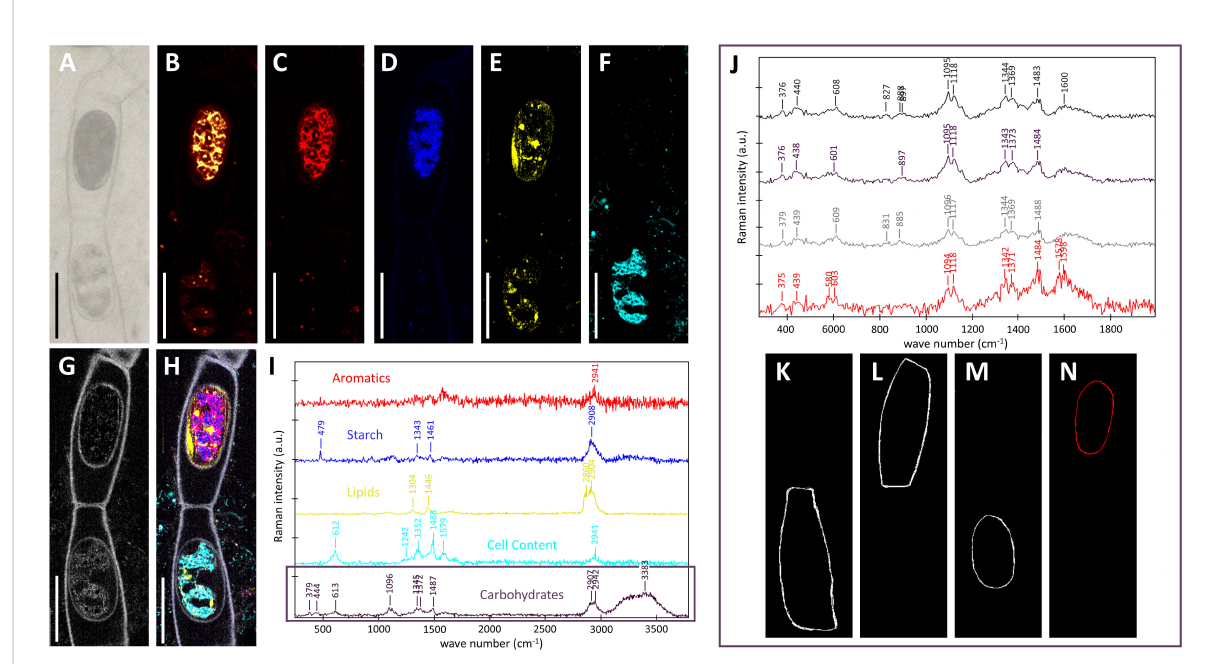
FIGURE 6 Raman imaging of two Spirogyra mirabilis zygospores (designated according to their position in the image as ‘ upper ’ and ‘ lower ’ zygospore), resulting from lateral conjugation and located in female gametangia. (A) light microscopical image; (B) fl uorescence image derived by plotting overall intensity at 2000 cm -1 (a region absent of bands); (C – I) results of True components analysis showing the distribution of (C) high fl uorescing cell content (aromatics); (D) starch; (E) lipids; (F) cell content with marker bands at 612, 1352, 1488 and 1579 cm -1 ; (G) cell wall; (H) combined image of all components and (I) the corresponding component spectra; (J) average cell wall spectra derived by marking; (K, L) the vegetative gametangium cell wall and (M, N) the zygospore cell wall. Scale bars 30